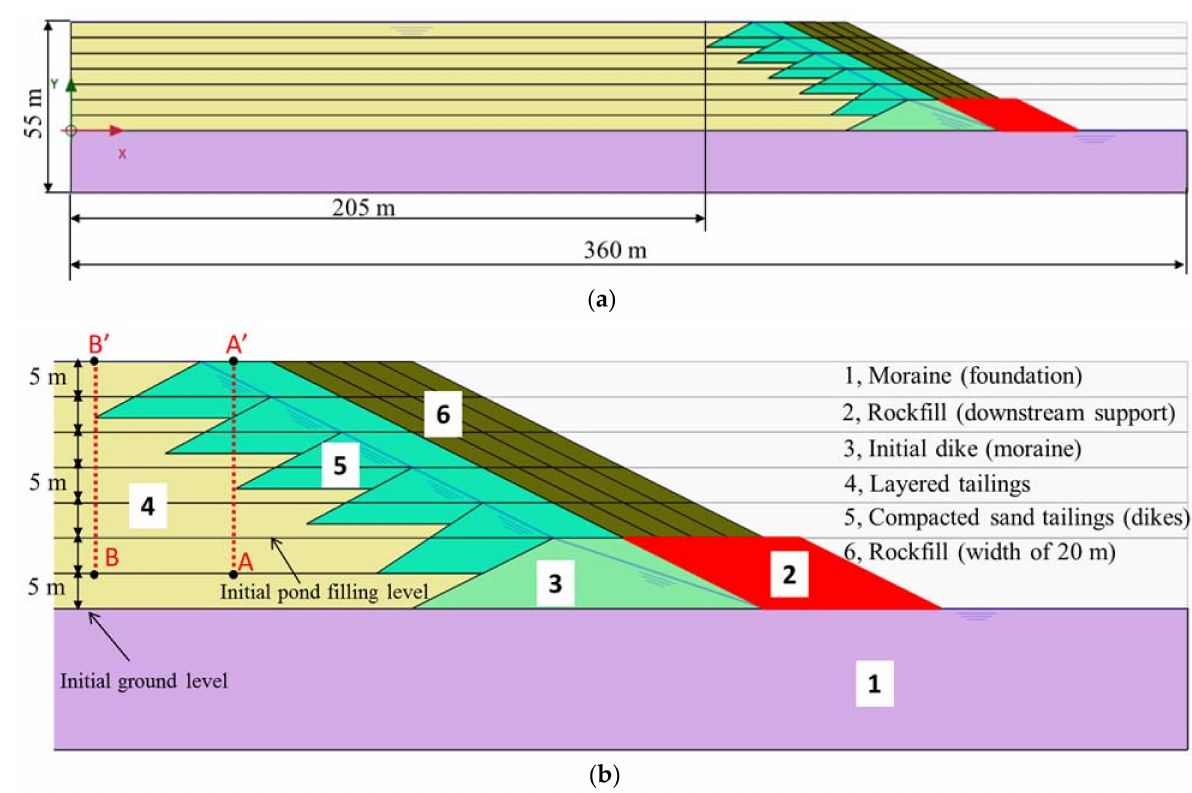
Figure 1. Geometry of the upstream tailings dam (rockfill width of 20 m): ( a ) full model and ( b ) upscaled model (down- stream part).